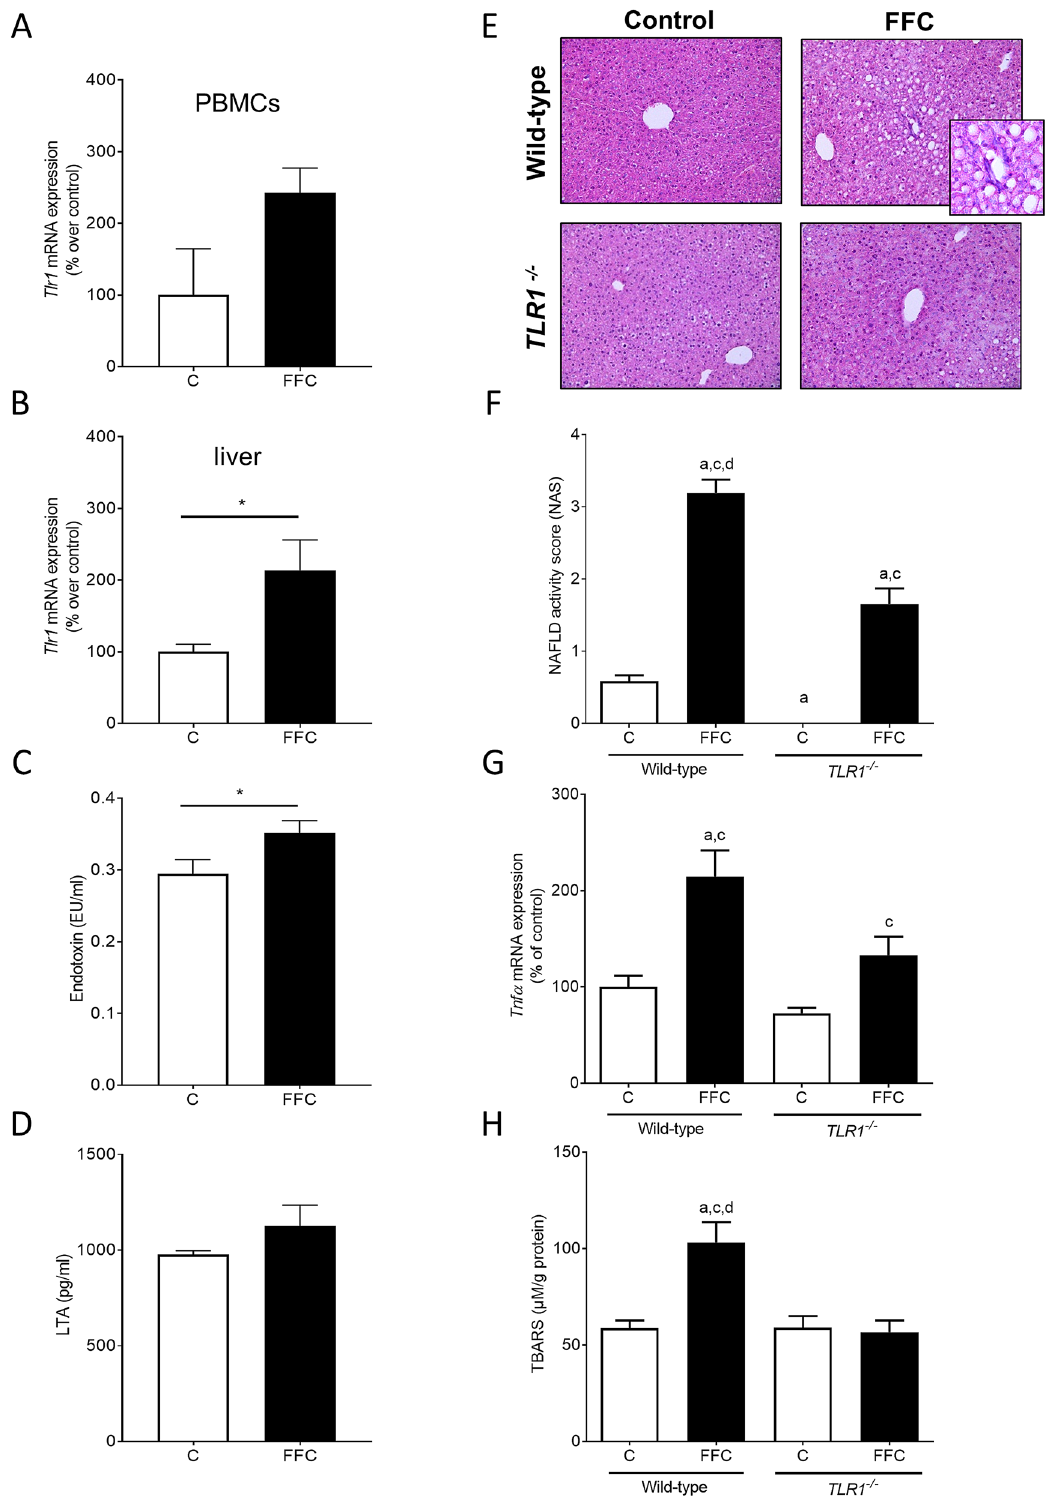
Figure 6. Effect of TLR1 on markers of intestinal permeability and indices of liver damage in FFC-fed mice. Tlr1 mRNA expression in ( A ) PBMCs and ( B ) liver tissue, ( C ) endotoxin concentration as well as ( D ) LTA levels in plasma of C- and FFC-fed wild-type mice. ( E ) Representative pictures (magnification ×200 and ×400) of hematoxylin and eosin staining and ( F ) NAFLD activity score (NAS) in liver tissue, ( G ) mRNA expression of Tnfα in liver tissue and ( H ) concentration of TBARS in liver tissue of C- and FFC-fed TLR1 −/− and wild-type mice. Data are shown as means ± SEM, n = 5–8, except of ( A ) as yield of PBMCs was rather low, 2 samples were pooled respectively and for ( D ): n = 4 in C-fed mice, * p ≤ 0.05 between C- and FFC-fed wild-type mice; a p ≤ 0.05 compared to C-fed wild-type mice; c p ≤ 0.05 compared to C-fed TLR1 −/− mice; d p ≤ 0.05 compared to FFC-fed TLR1 −/− mice. C control diet, FFC fat-, fructose- and cholesterol-rich diet, LTA lipoteichoic acid, PBMCs peripheral blood mononuclear cells, TBARS thiobarbituric acid reactive substances, Tlr toll-like receptor, Tnf tumor necrosis